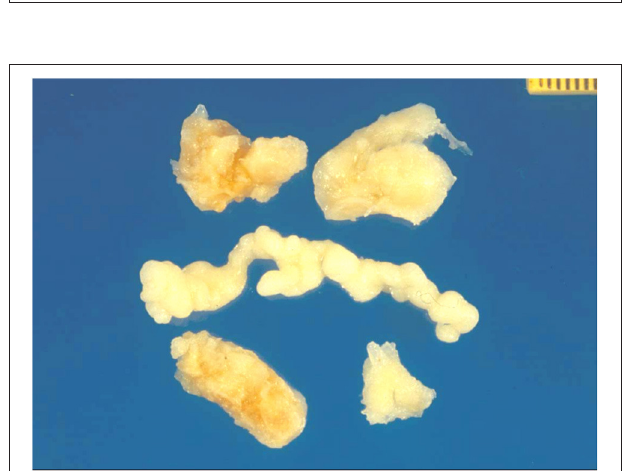
upper limb motility and aphasia. Conjugate eye left deviation is unchanged.